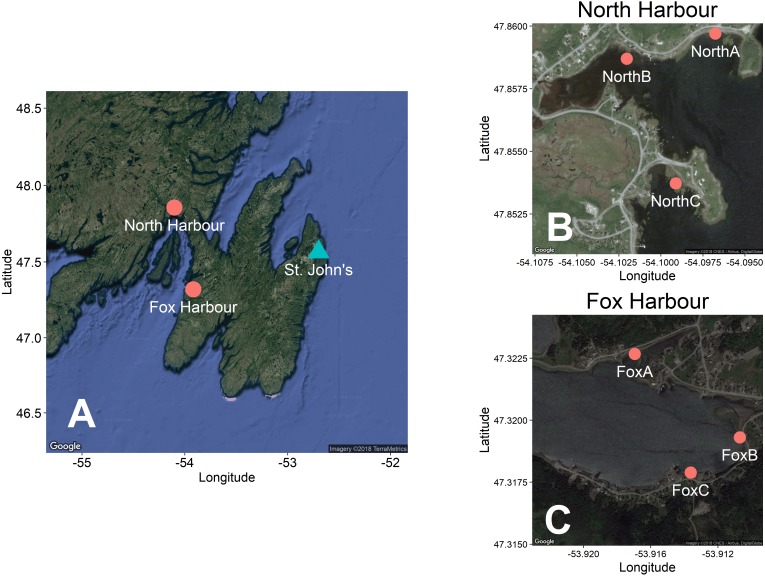
Maps showing the location of our study sites and experimental blocks.(A) shows the location of North Harbour, NL and Fox Harbour, NL. The city of St. John’s, NL is included for reference. (B–C) show the location of our experimental blocks at North Harbour and Fox Harbour, respectively. We produced these maps using the ggmap package (Kahle & Wickham, 2013) in R (R Core Team, 2015). Map A imagery ©2018 TerraMetrics. Map B and C imagery ©2018 CNES/Airbus, DigitalGlobe.